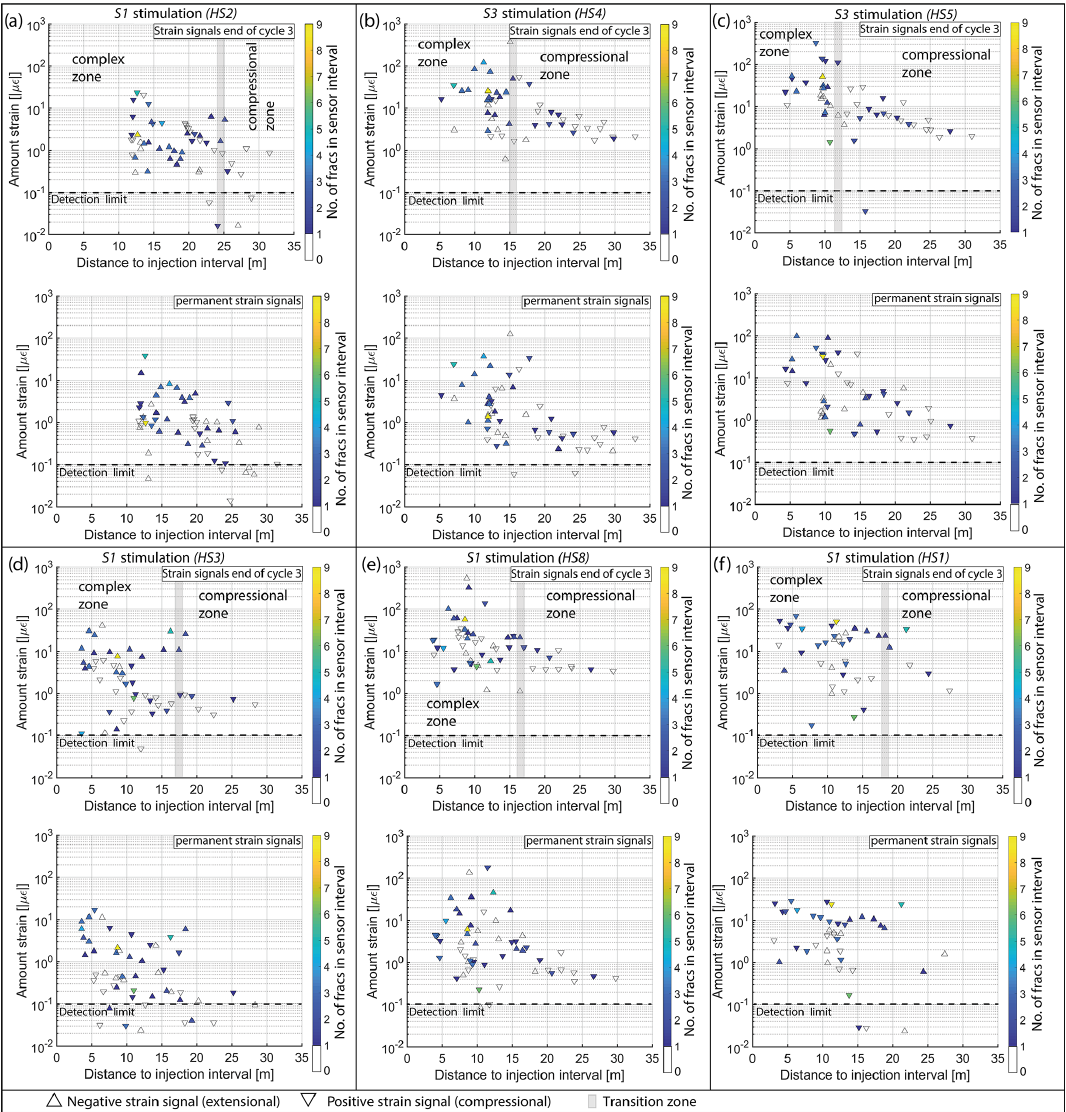
Figure A8. Strain signals with respect to distance to the injection point for all experiments. The variable and compressional strain fields are labeled during